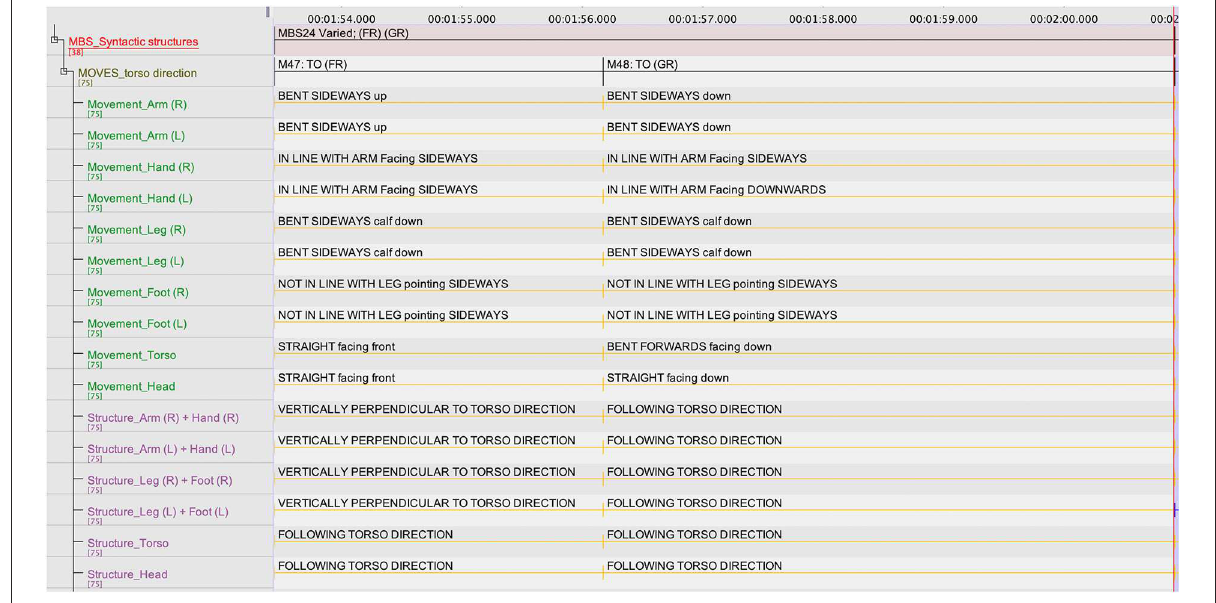
FIGURE3 The tier at MBS level (MBS 24) and the tiers at move level ( moves 47 and 48) coding physical movements and projection structures.